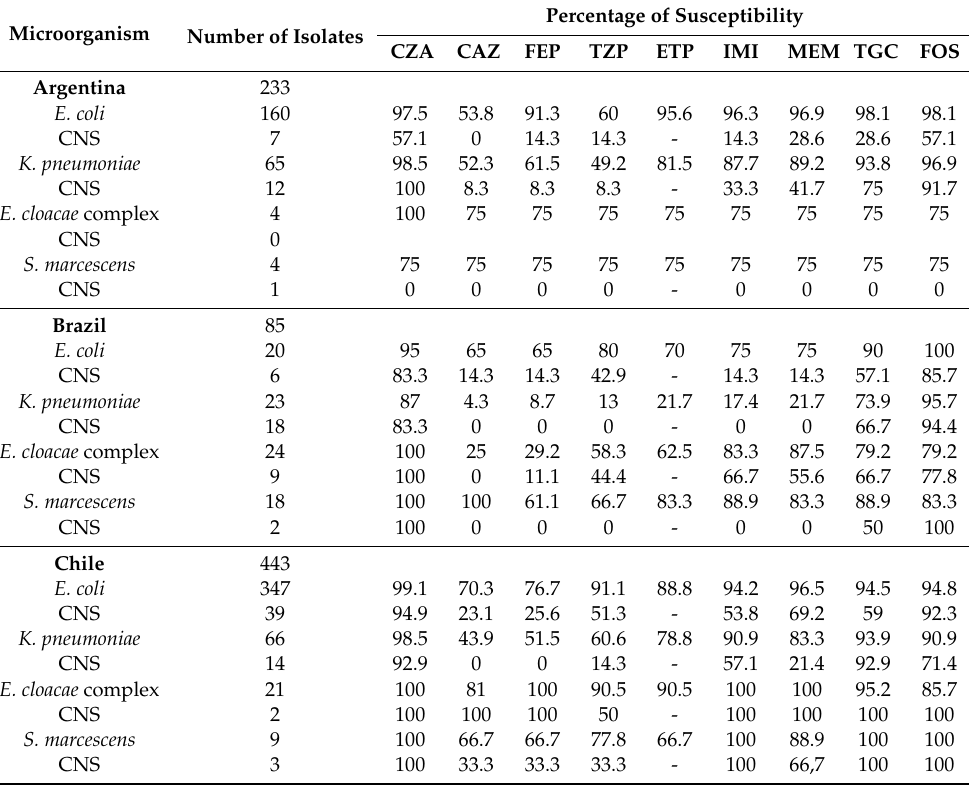
Table 1. Susceptibility of Enterobacterales to ceftazidime / avibactam and comparators by country.